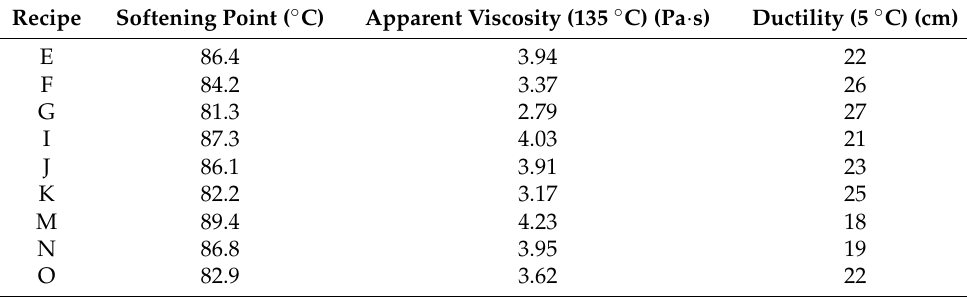
Table 5. Physical properties of composite-modified